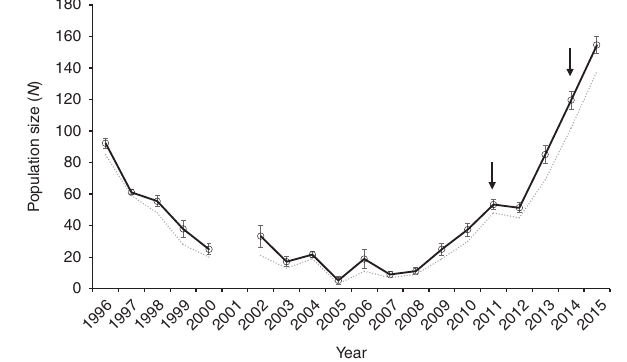
Fig. 1 Burramys parvus adult population size. Estimates are for the Federation-Wombat bowl area at Mount Buller based on the capture- recapture data. Solid line is the estimate based on the robust design model 22 with standard error (mean) bars. Dashed line represents the number of unique observed individuals. Arrows indicate the 2011 and 2014 introduction of six males from each of Mount Higginbotham and Timms Spur in the central region (Supplementary Fig. 1)